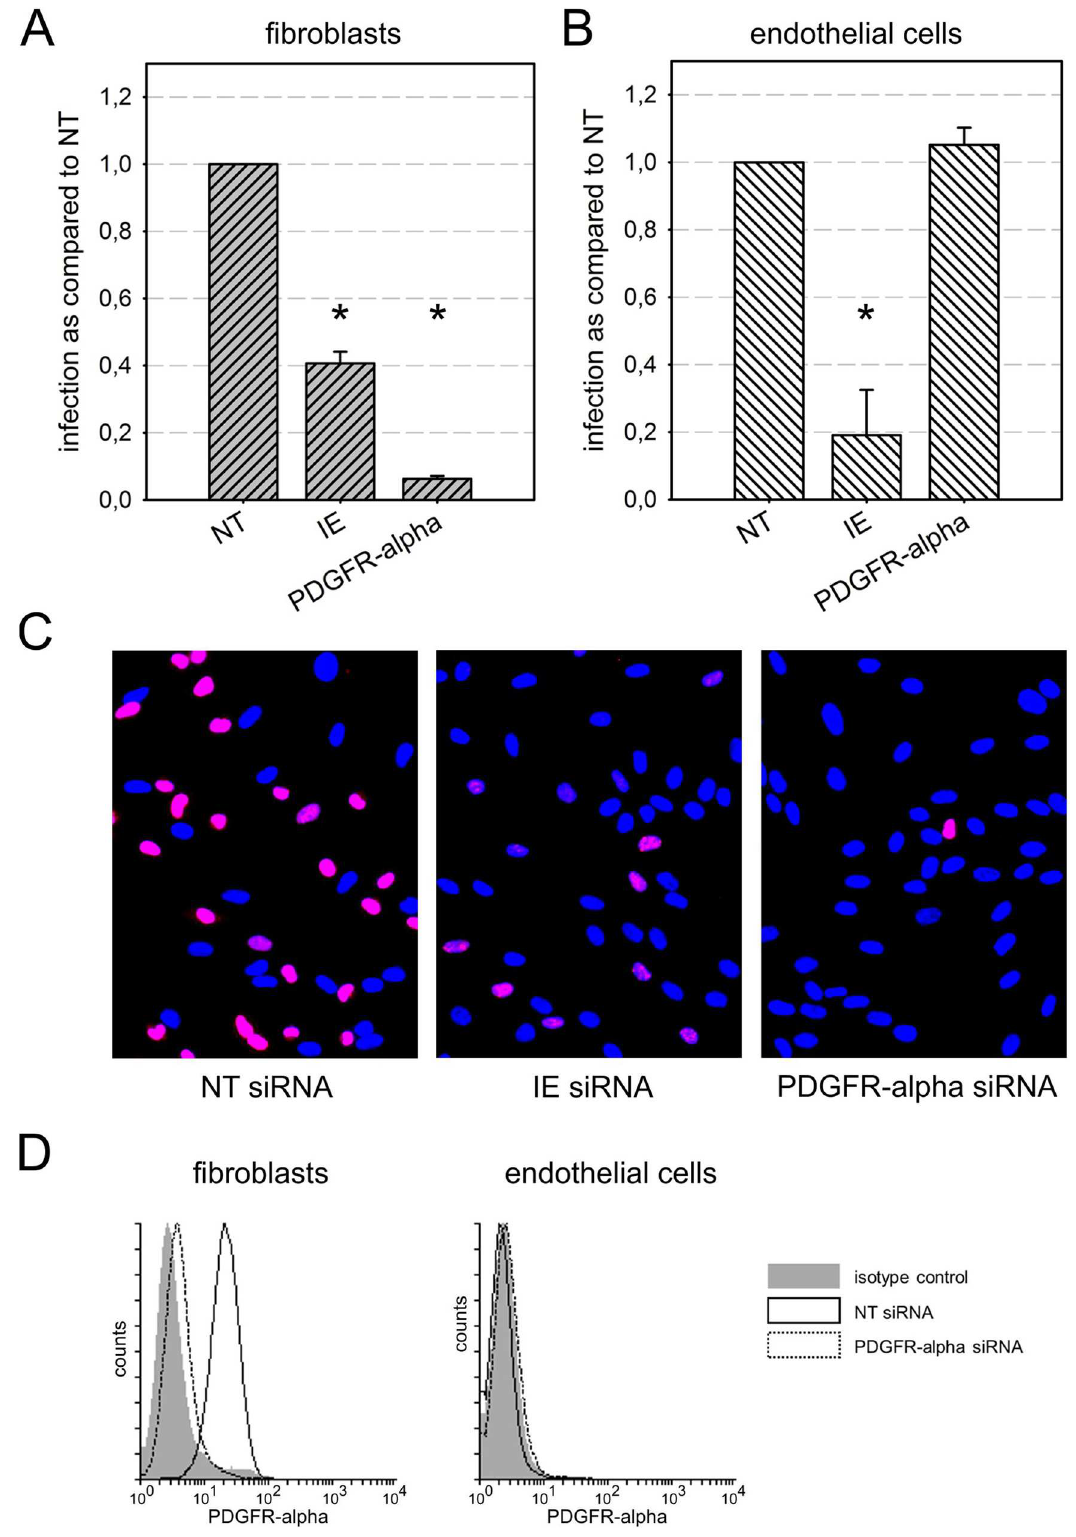
Fig 1. Effect of siRNA-mediated depletion of PDGFR-alpha on infection efficiency in fibroblasts and endothelial cells. Fibroblasts (A) and endothelialcells (B) were transfected with siRNAs targeting PDGFR-alpha. Non-targeting